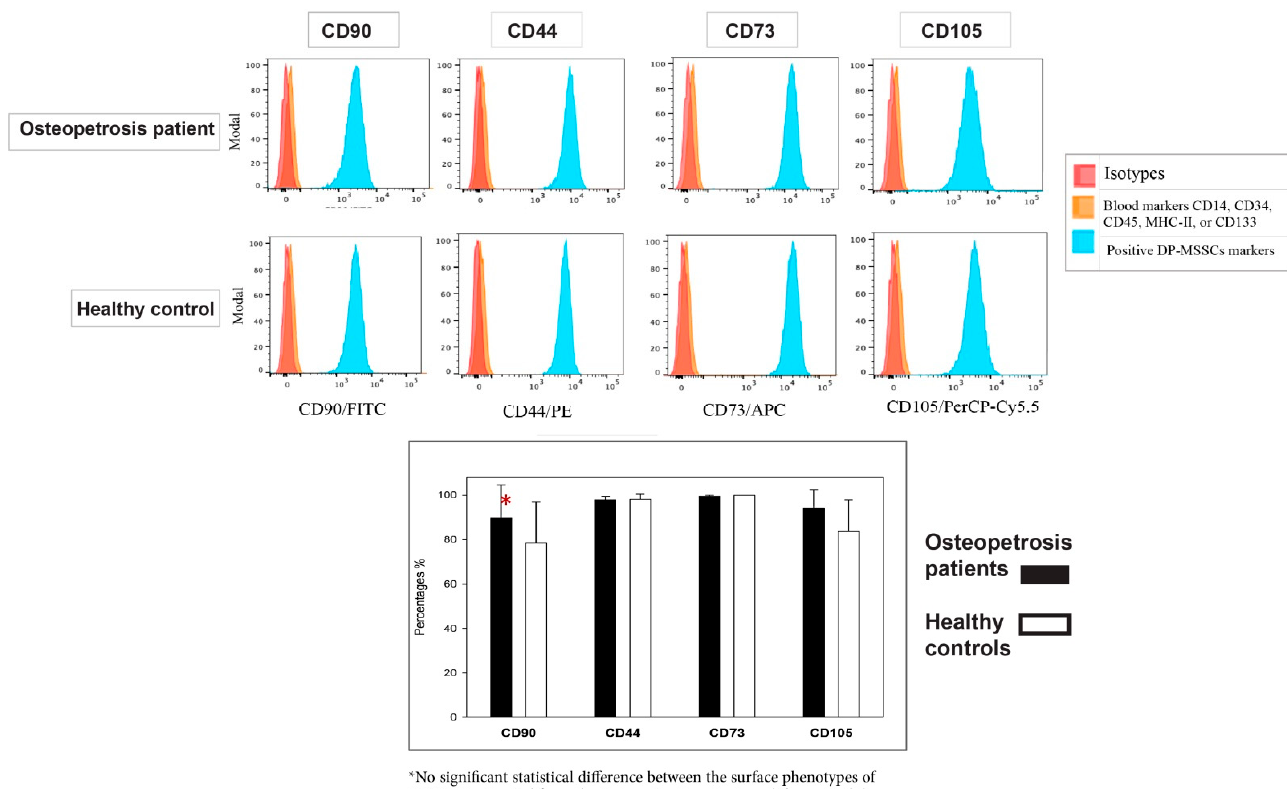
Figure 4. The comparisons of surface markers of DP-MSSCs from normal donors and osteopetrosis patients using flow cytometry. Representative histograms showing the expression of MSC surface markers (CD90, CD44, CD73, and CD105) as analyzed by flow cytometry. The graph shows a comparison of MSC markers (average mean ± 95% confidence intervals) of 15 clones of DP-MSCs extracted from different human exfoliated deciduous teeth. Seven clones from osteopetrosis patients (black bars) and eight clones from normal donors (white bars) were analyzed by flow cytometry. Means and percentages are given, and error bars are 95% confidence intervals. In the green histograms (isotype), samples from both normal and patients were negative for hematopoietic markers (CD14, CD34, CD45, MHC-II, or CD133) (blue histograms). The blue histograms show positive markers in isolates from normal donors (8) and osteopetrosis patients (7), and negative blood markers are represented by orange and pink histograms as isotope controls. * indicates no statistical significance ( p > 0.05).